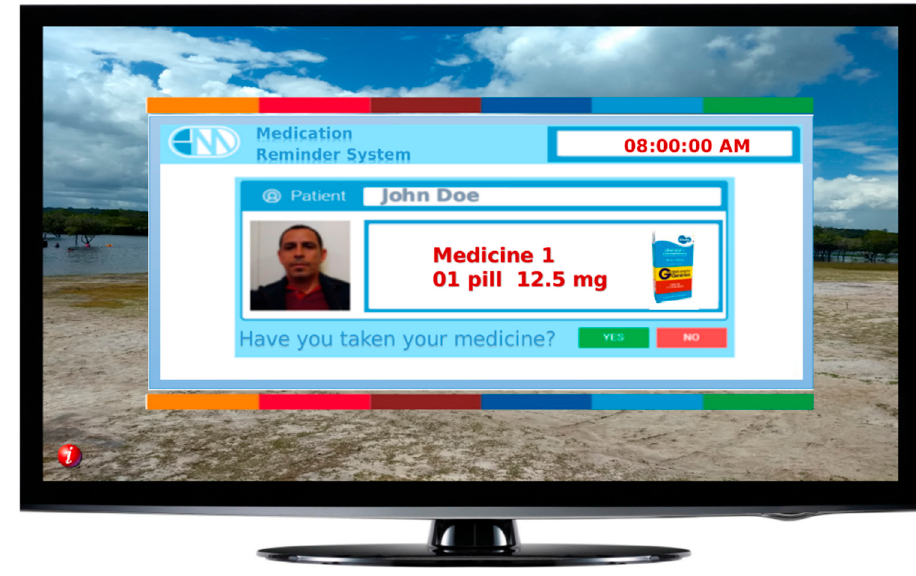
Figure 5. Smart TV warning for medication-intake example. Sensors 2019 , 19 , 4539